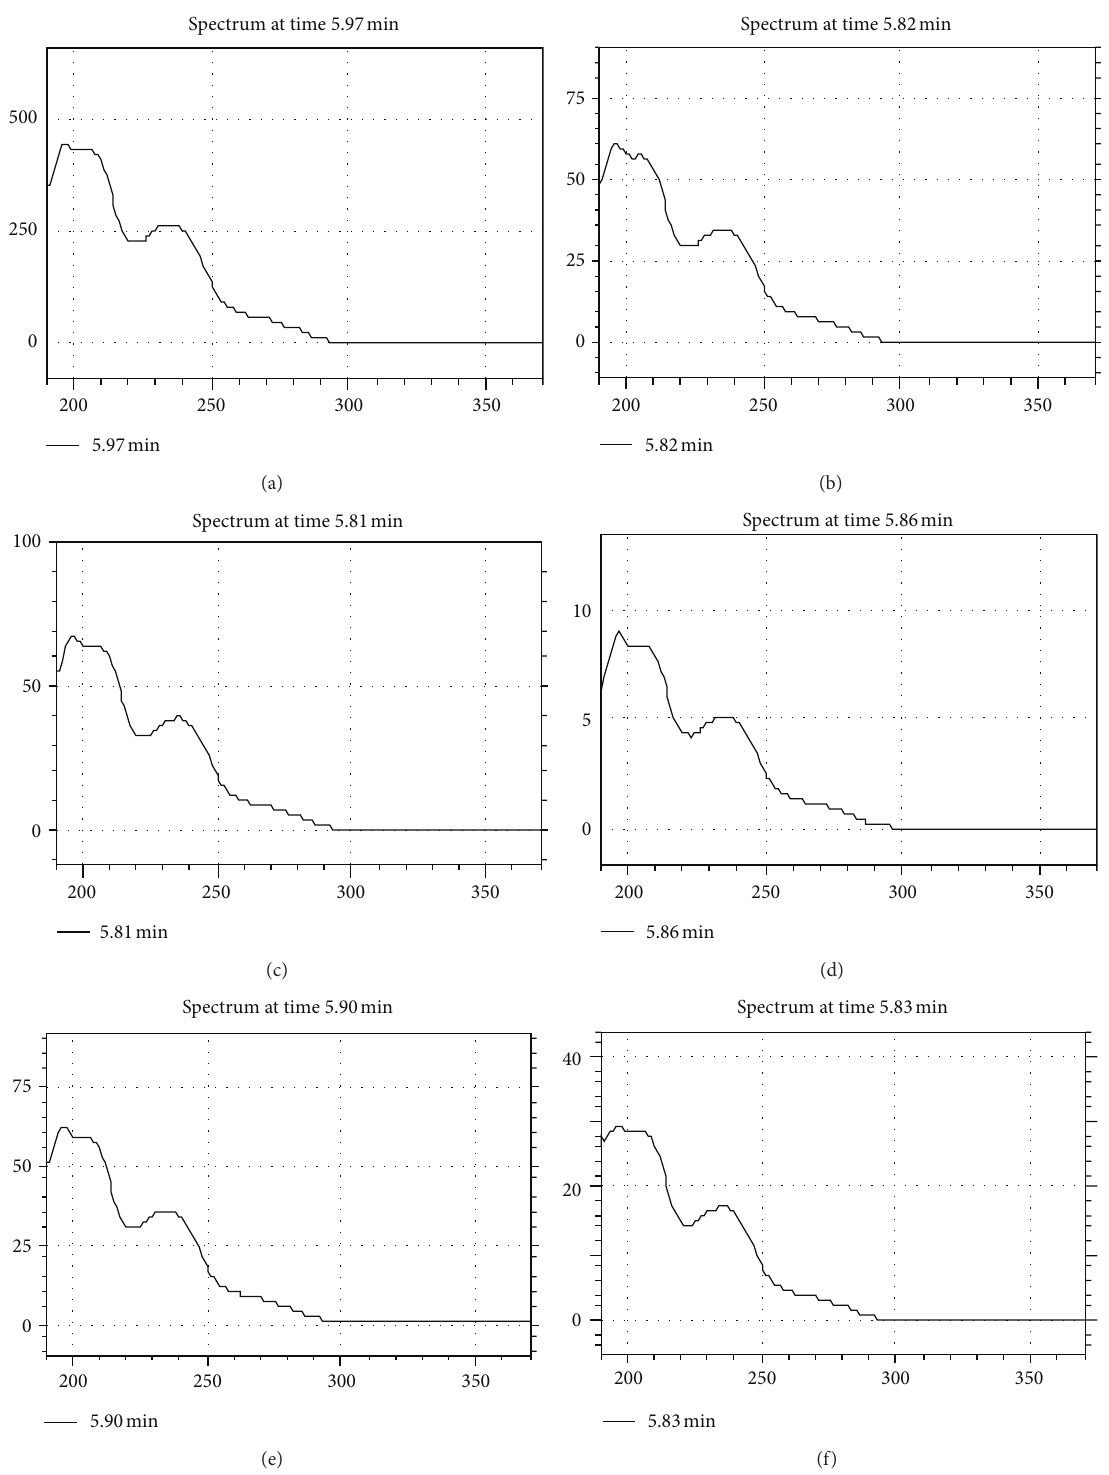
Figure 4: Typical spectrums of (a) diltiazem working standard solution and after degradation under (b) heat condition; (c) acidic hydrolysis; (d) basic hydrolysis; (e) oxidative condition; (f) photolytic